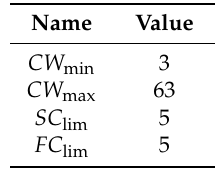
Table 1. Parameters and their values in the improved backoff